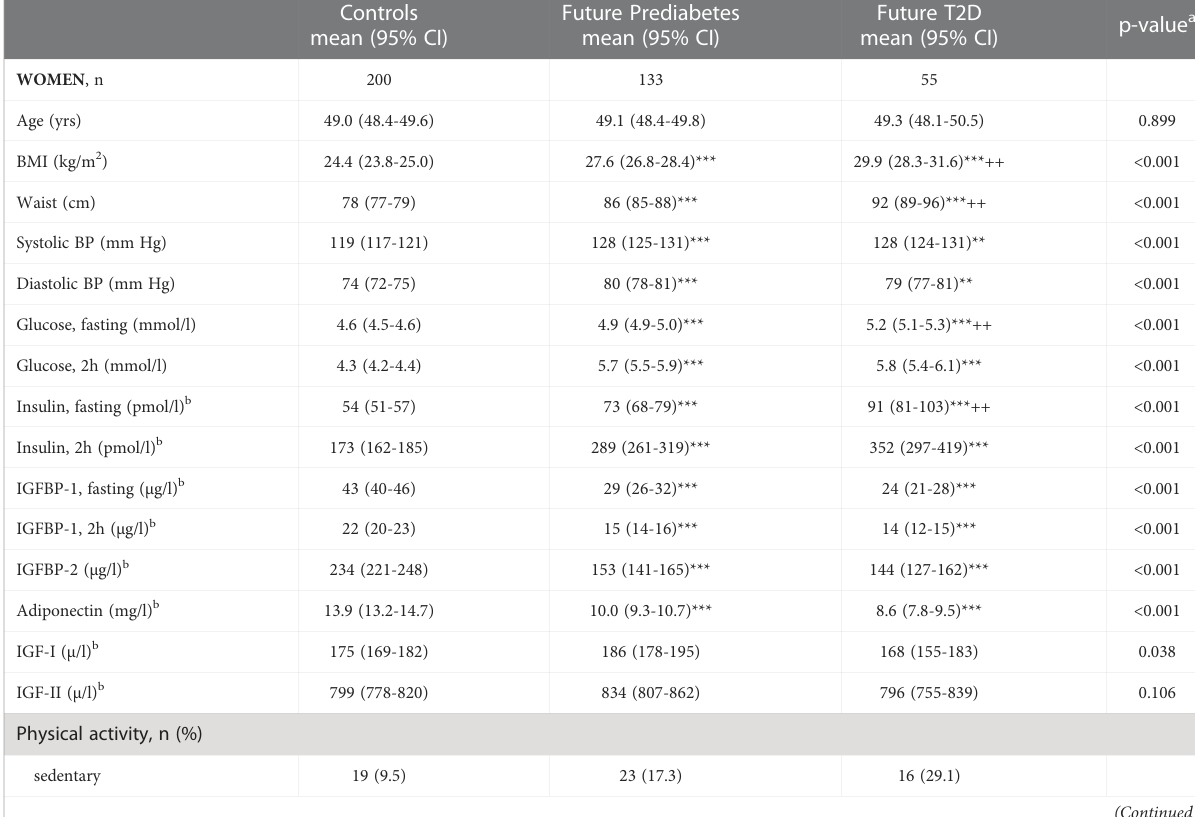
(Table 1). Socioeconomic position, based on self-reported TABLE 1 Characteristics at baseline in women and men according to glucose tolerance at